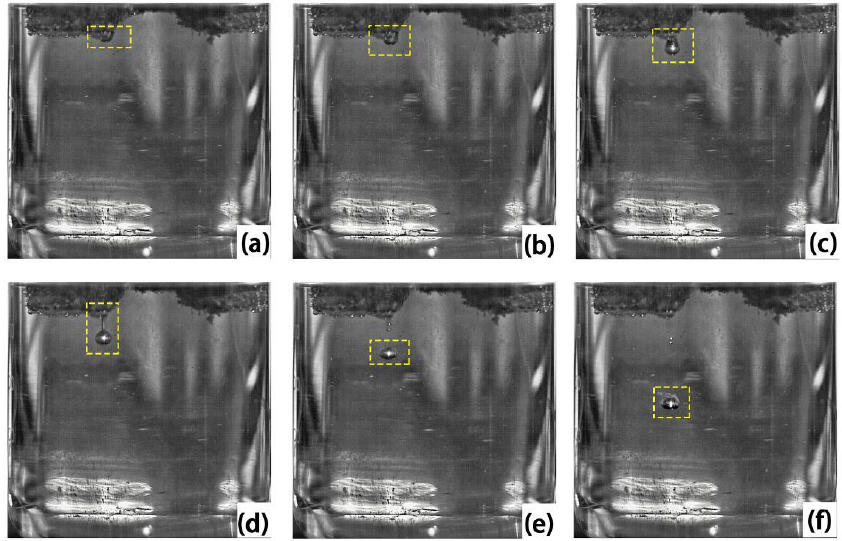
Figure 8. Formation and dripping process of droplet in physical simulation. ( a ) 0.31 s; ( b ) 0.49 s; ( c ) 0.77 s; ( d ) 0.87 s; ( e ) 0.93 s; ( f ) 1.01 s.